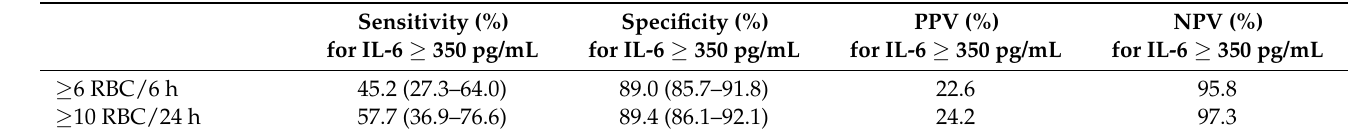
Table 3. Massive transfusion prediction of IL-6 > 350